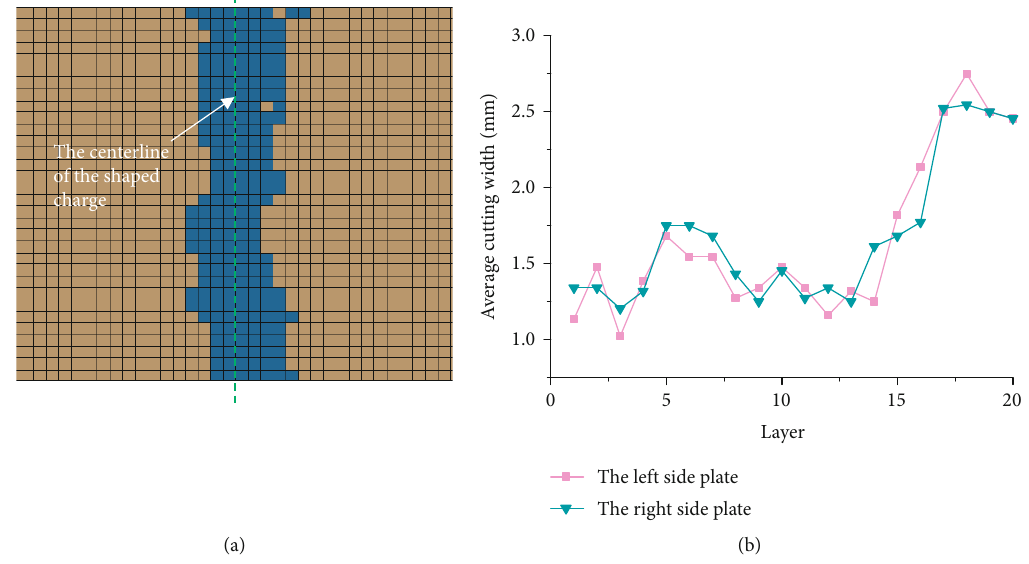
Figure 8: Cutting width. (a) Statistical view of cutting width (blue elements represent failure elements). (b) Average cutting width of the